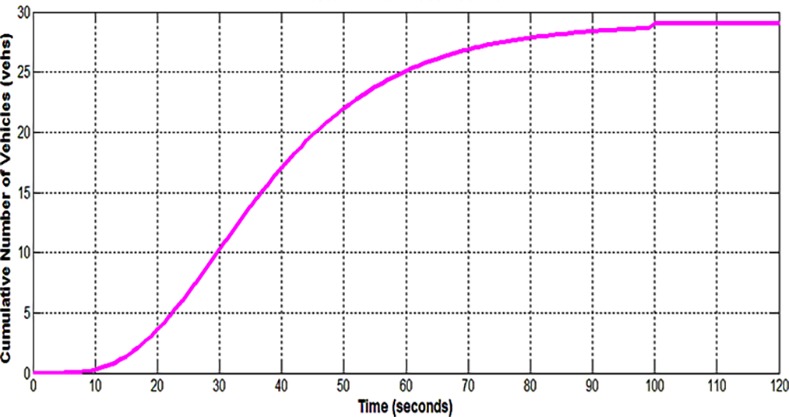
Cumulative platoon arrival profile from LWR-VCPN.